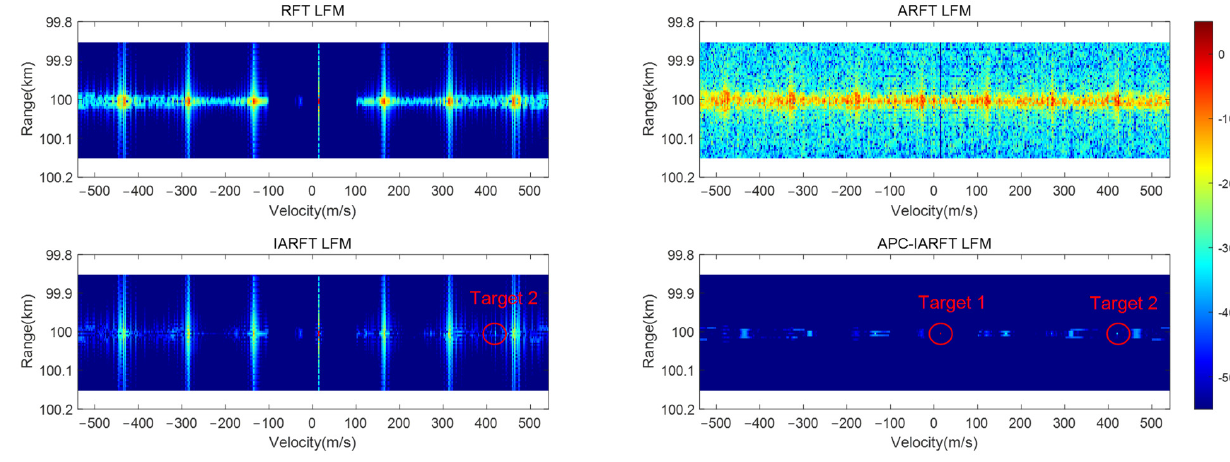
Figure 6. Plan output of four methods in Scenario 1.